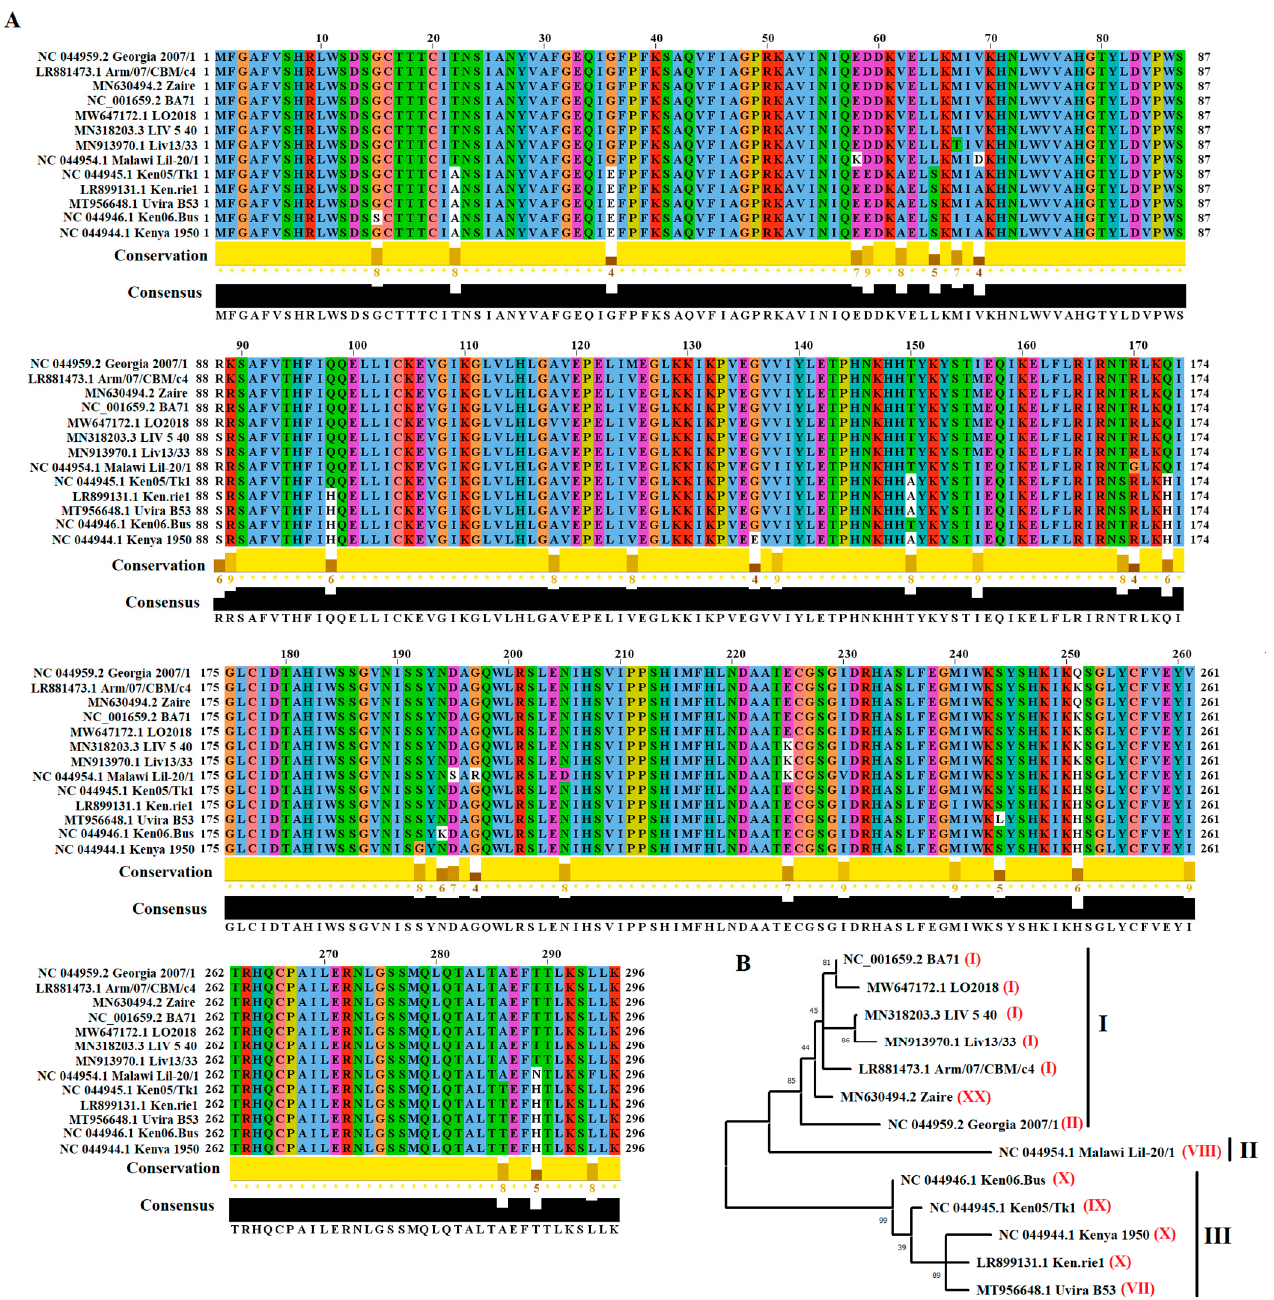
Figure 1. Evolution of EP296R protein among ASFV isolates. ( A ) Amino-acid alignment produced by the software Jalview version 2.11.1.7 showing the diversity of EP296R protein among a group of 13 representative ASFV isolates. Conservation plot scores reflected the nature of the change in specific sites, as high scores were associated with changes with similar biological properties. ( B ) Phylogenetic analysis conducted by the neighbor-joining method and the p -distance model, showing the diversity of EP296R protein of ASFV in the field. On the basis of the cluster distribution, isolates were classified in three main groups (I, II, and III). Numbers in the parenthesis (red), show the genetic lineage classification of different ASFV isolates based on p72 classification. Numbers above internal branches represent bootstrap values (1000 repetitions). Phylogenetic analysis was conducted using the software MEGA 10.2.5.